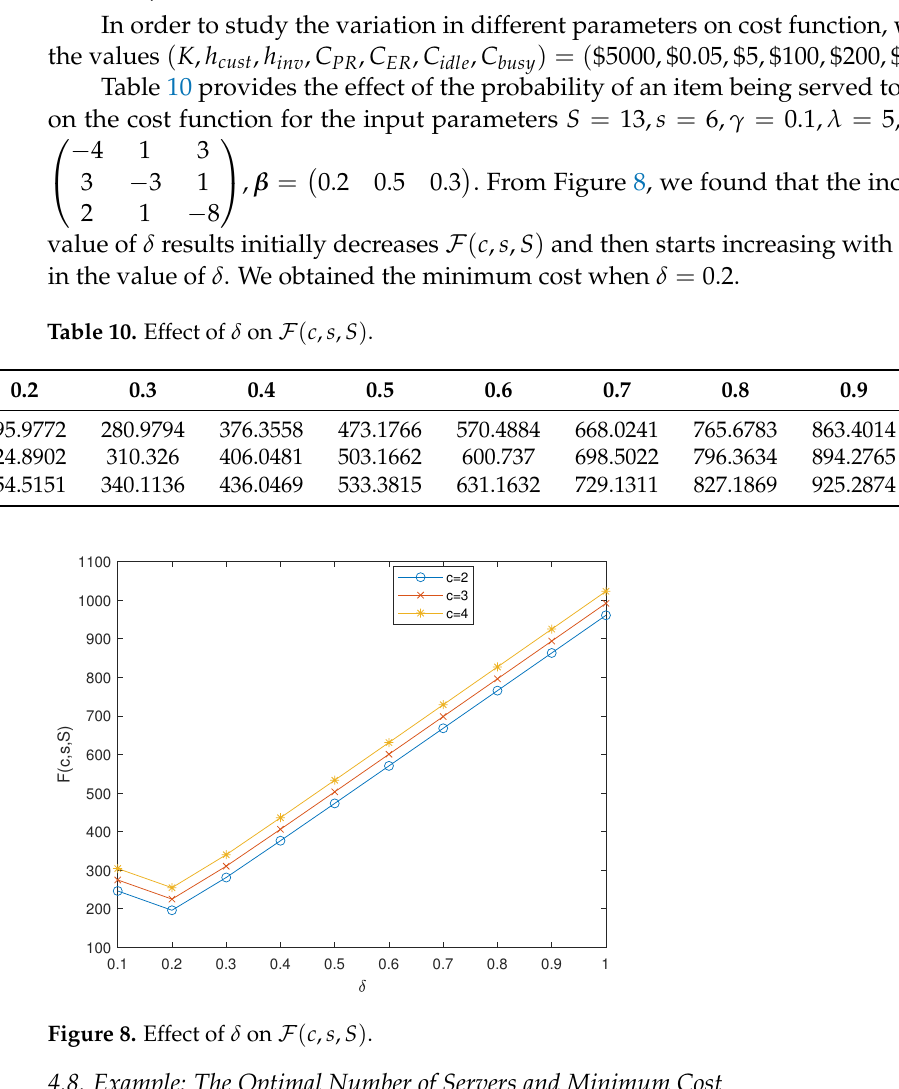
( c , s , S ) Figure 8. Effect of δ on F